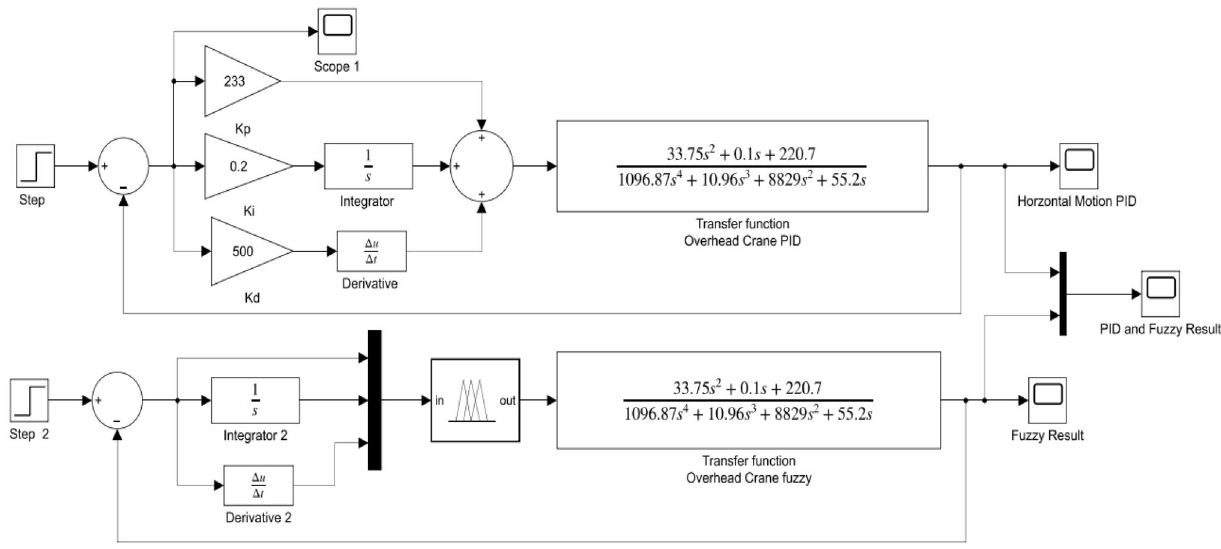
Fig. 13 Simulink model for both conventional PID controller and FLC for horizontal motion of the crane